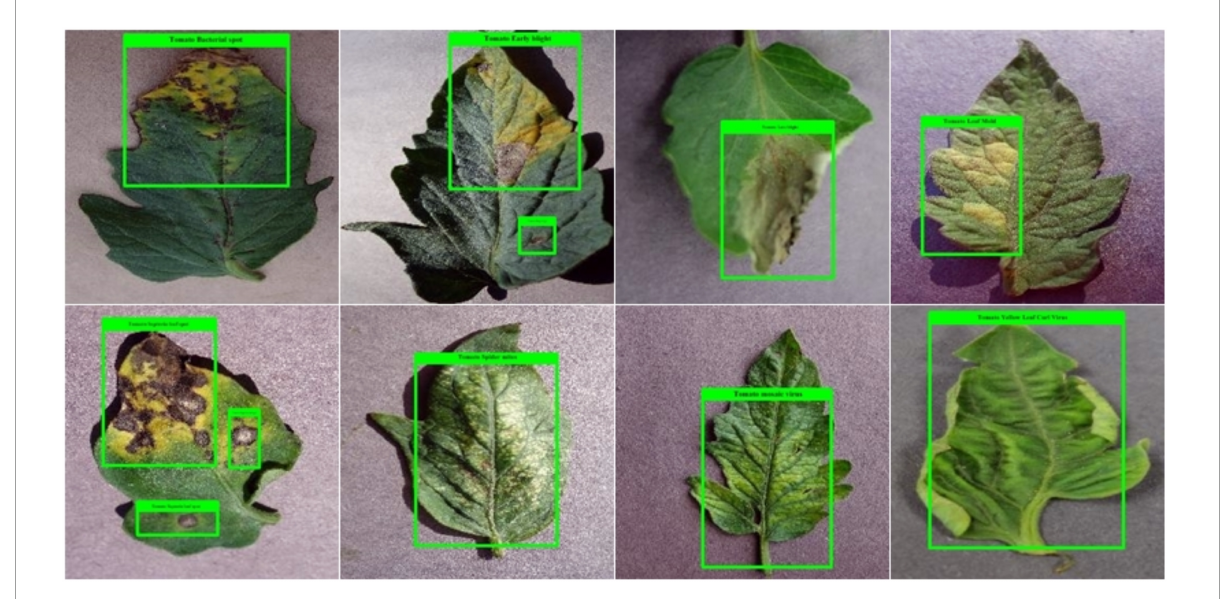
FIGURE2 Example of annotated images of the tomato plant from the PlantVillage